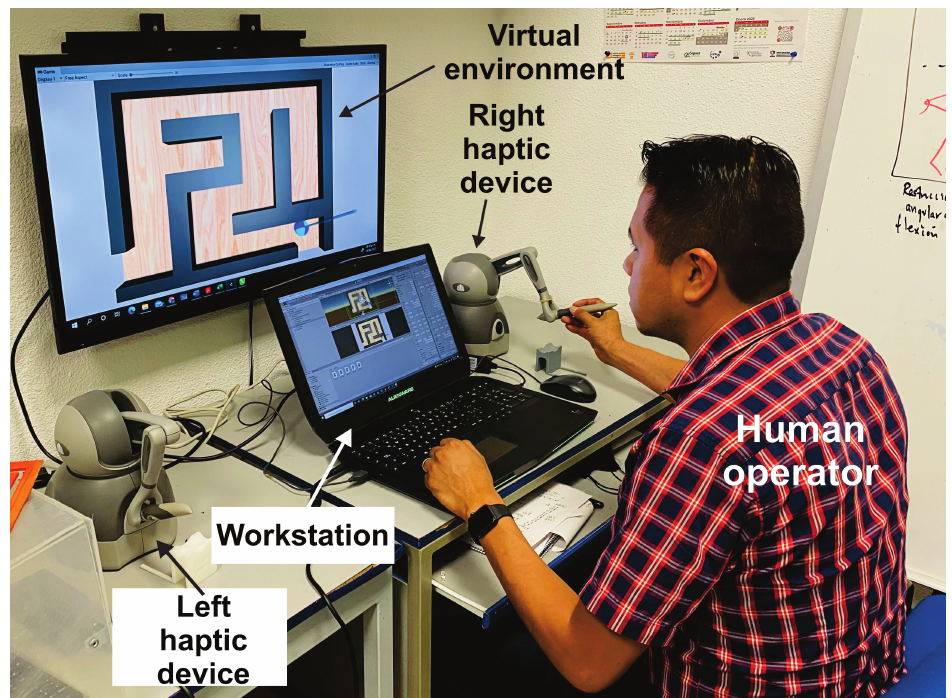
Figure 7. Experimental platform shows the user solving a virtual maze with a his right hand, which commands a (right) haptic